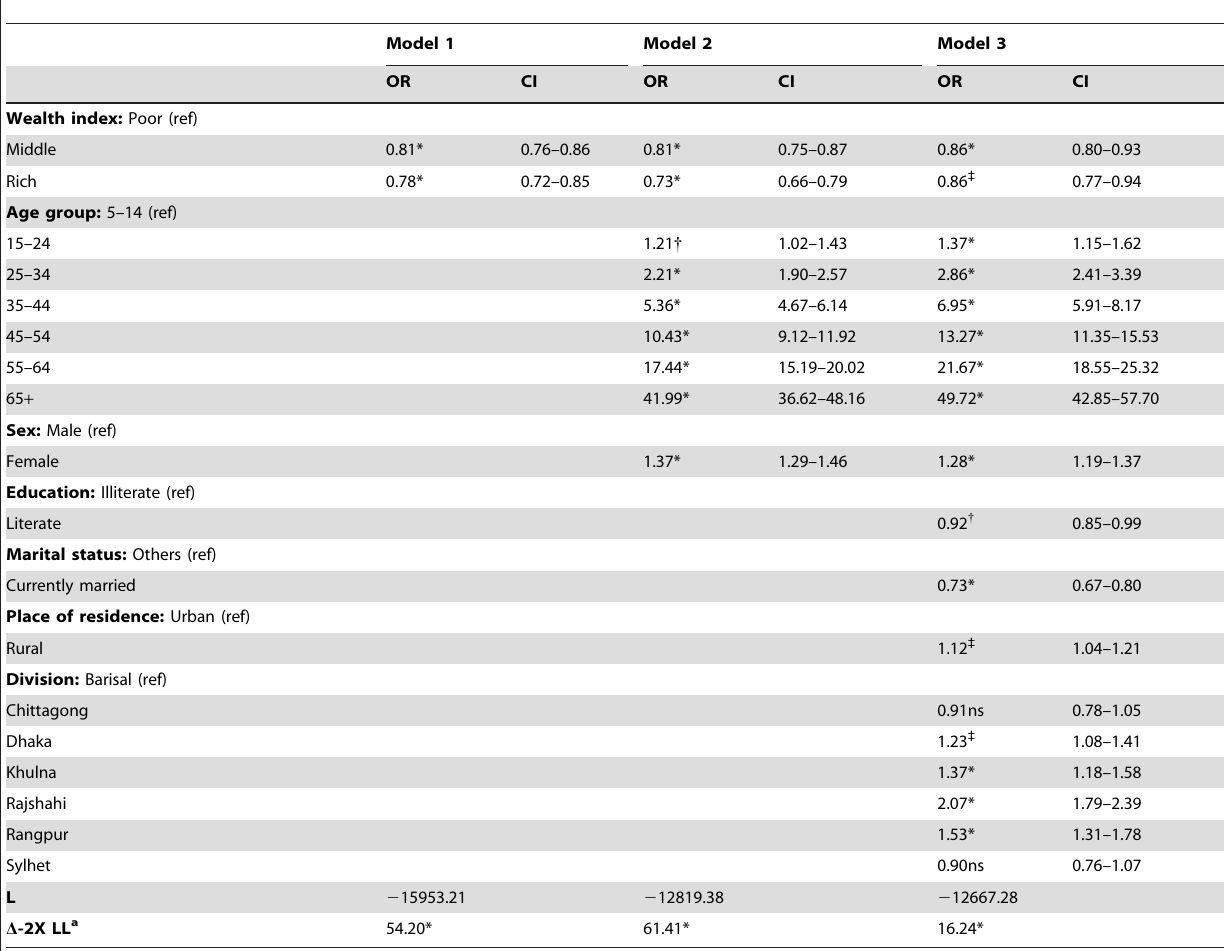
Table 4. Odds ratio for an individual having a disability versus no disability in